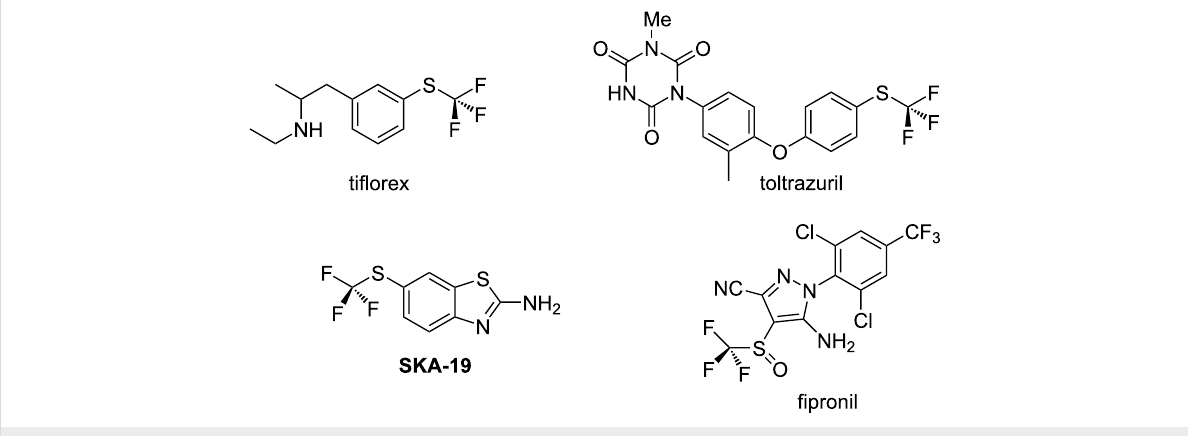
Figure 1: Structures of trifluoromethyl sulfonyl ether bioactives.